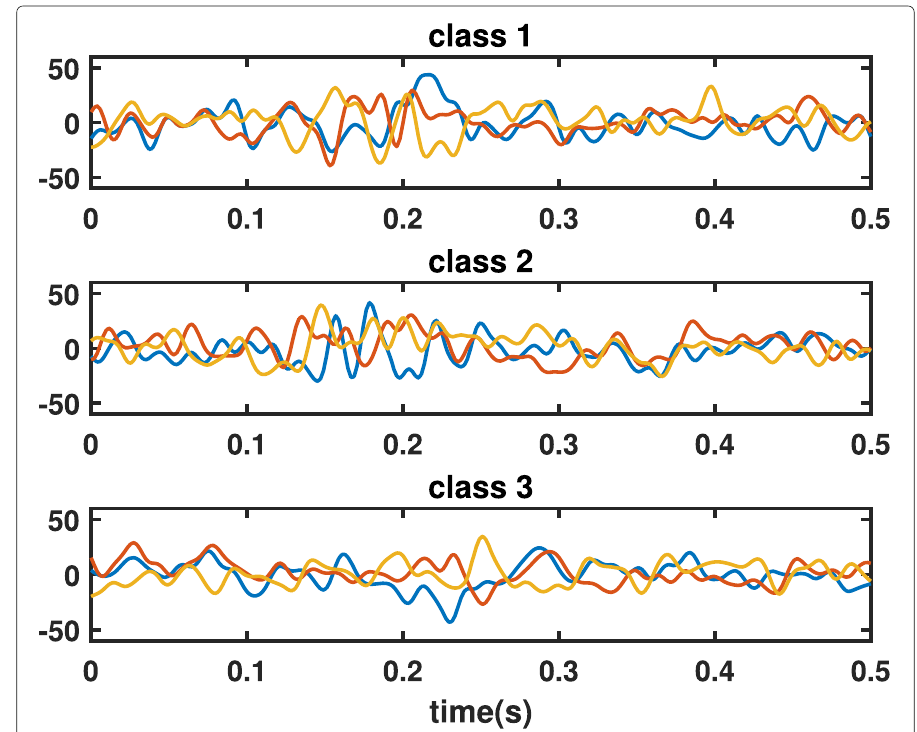
Fig. 7 Examples of realizations from the three classes of simulated stochastic signals